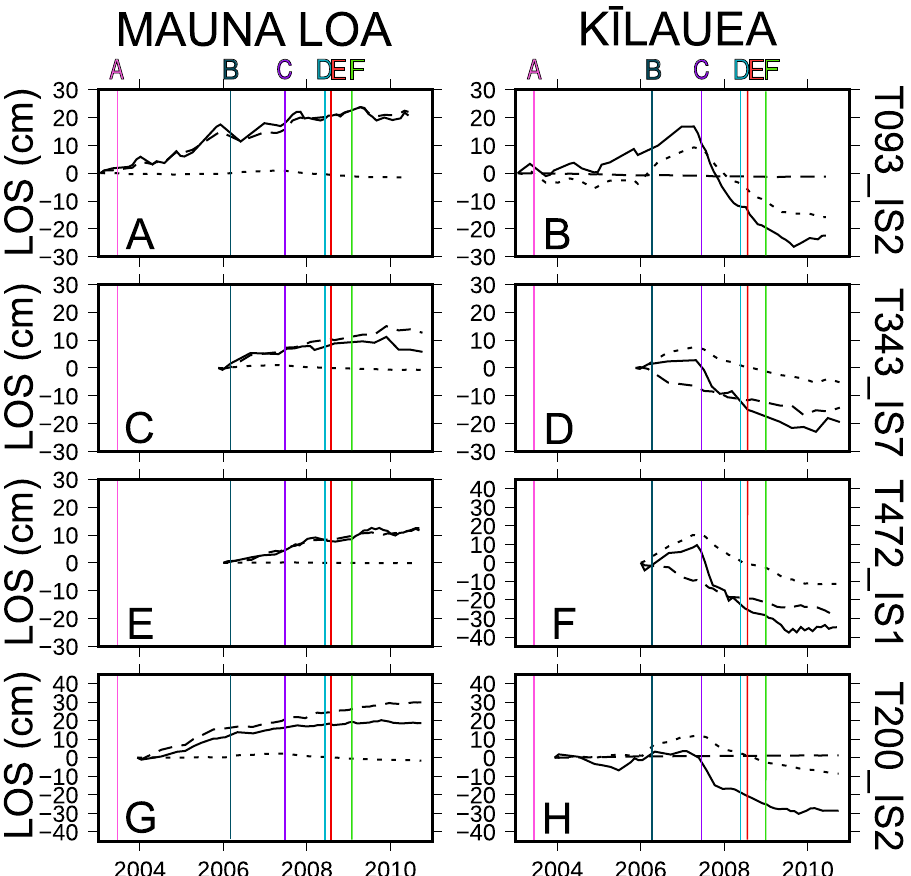
Figure 3. LOS displacement time series of Mauna Loa and Kīlauea summits. ( A ), ( C ), ( E ), ( G ): time series for LOS displacement of Mauna Loa; ( B ), ( D ), ( F ), ( H ): time series for Kīlauea volcano. Time series of LOS data are shown with continuous black lines; time series of the first component of ICA are indicated with the dashed black lines, while the dotted black lines report the time series of the second component of ICA. Vertical lines mark major volcanic episodes and the date of the beginning of the GPS dataset: ( A ) Mother’s Day flow, which began erupting from Pu’u ’Ō’ō on 12th May 2003; ( B ) small bench collapse on 30th July 2006; ( C ) Father’s Day eruption on 17th June 2007; ( D ) explosion on 19th March 2008; ( E ) the second half of 2008 which represent the time interval where the GPS measurements are available; ( F ) active vent within Halema’uma’u crater in January